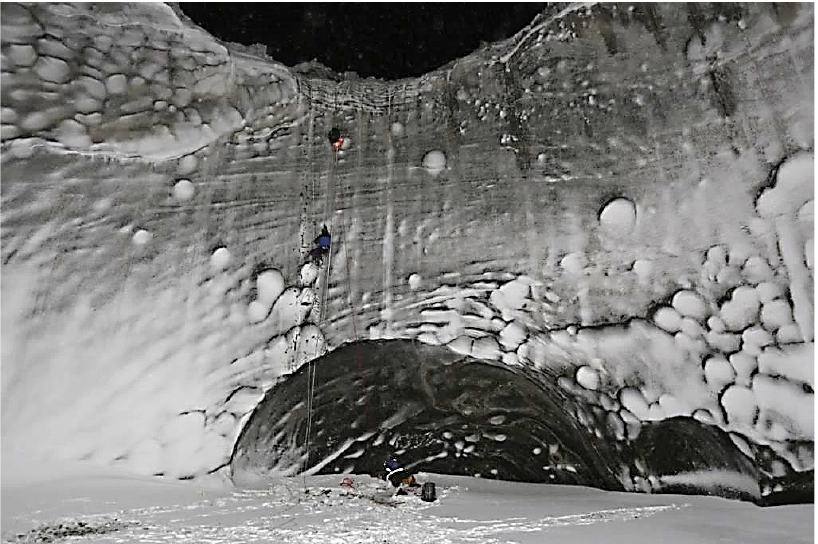
Figure 3. Large grottoes formed due to the amalgamation of a series of small depressions. November 2014. Photo credit: V.A. Pushkarev.